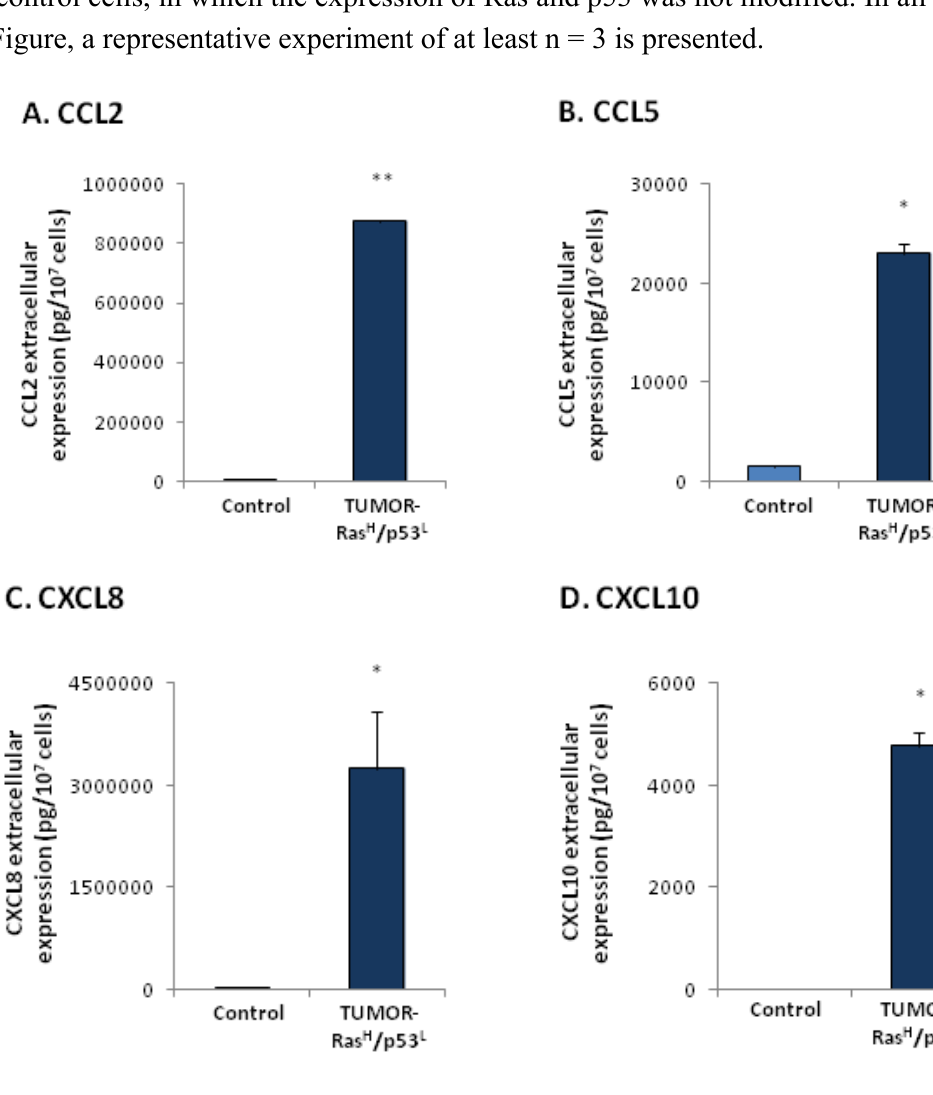
Figure 3. TUMOR-Ras H /p53 L cells release exacerbated levels of the cancer-related chemokine cluster. In-culture cells expressing oncogenic Ras and dysfunctional p53 (by shRNA), namely Ras H /p53 L -in-culture cells, were inoculated to mice and formed tumors. Cells that have been excised from these tumors [4] were termed TUMOR-Ras H /p53 L cells. The expression of chemokines in supernatants of TUMOR-Ras H /p53 L cells was determined by sandwich ELISA assays, at the linear range of absorbance. ( A ) CCL2. ( B ) CCL5. ( C )